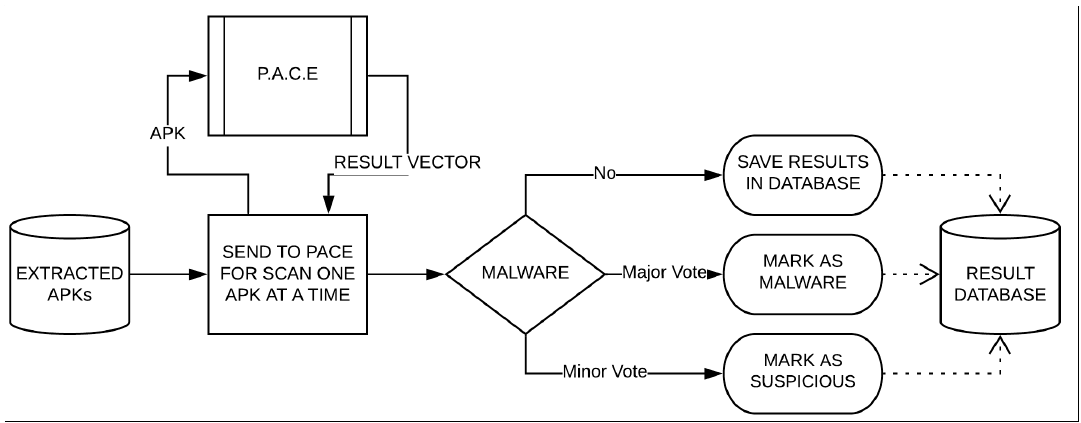
Figure 6. Flowchart of